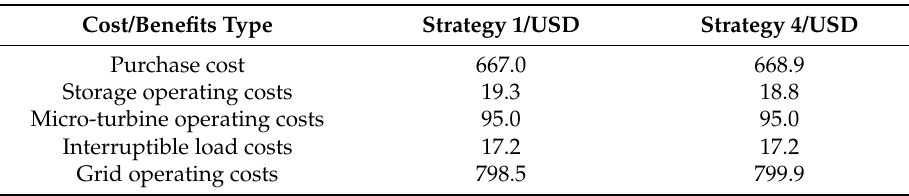
Figure 12. Results of intra-day optimal dispatch with Strategy 4: ( a ) Power curves of each device; ( b ) state of energy storage. Table 5. Cost and benefit of Strategy 1 and Strategy